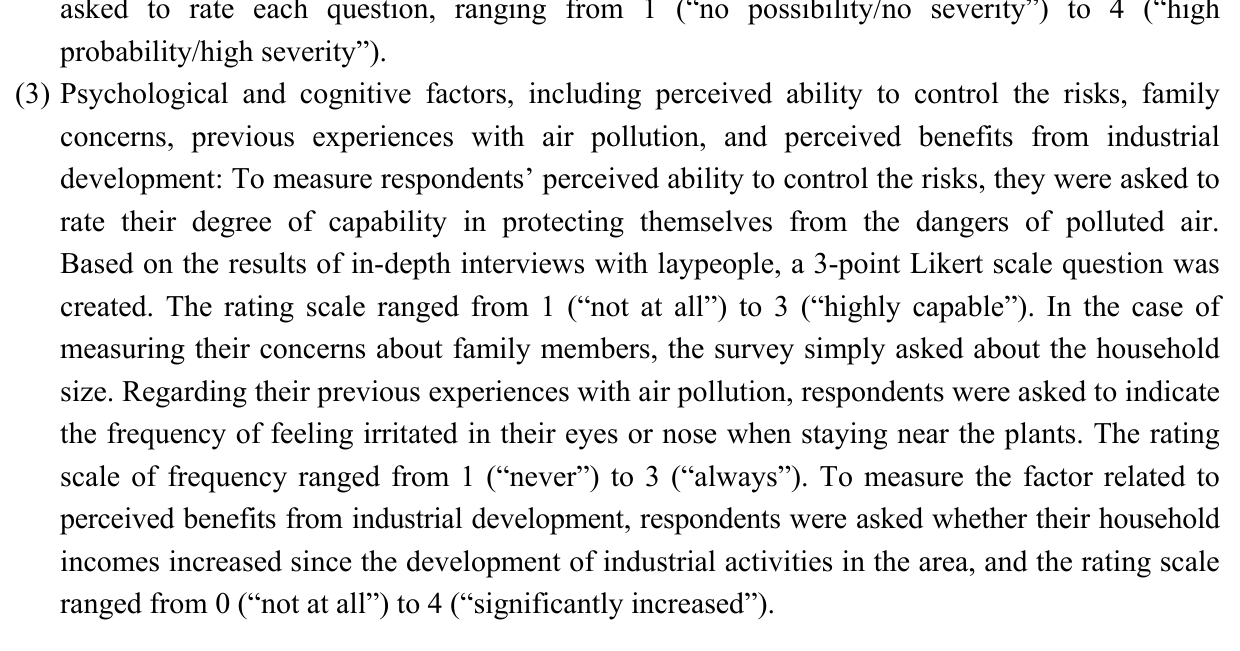
Table 3. Factors, variables, and development of